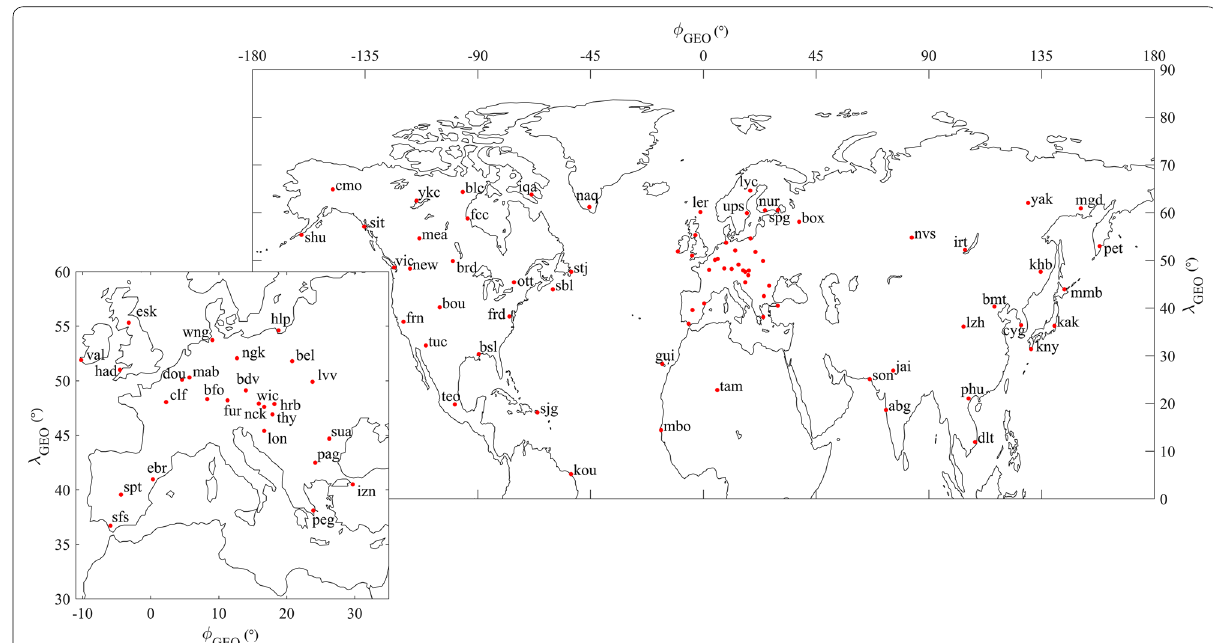
Fig. 2 Name and location (red dots), in terms of geographical coordinates, of the 75 INTERMAGNET stations used for the evaluation of the ionospheric current pattern associated with the